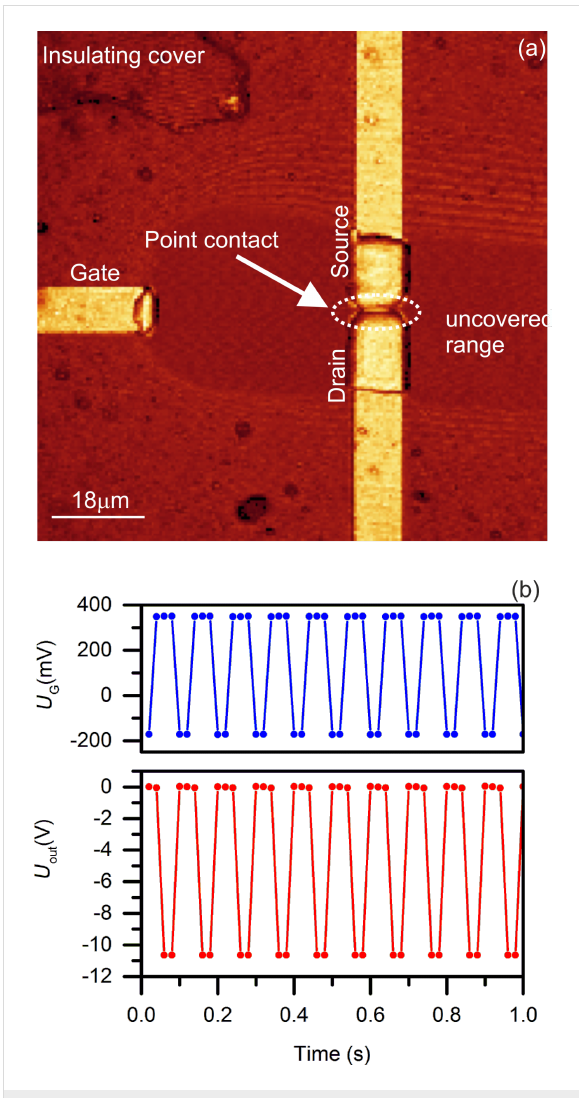
Figure 7: Influence of the copper electrolyte additives on the morphol- ogy of deposited copper film. (a) Confocal optical microscopy image of the copper atomic-scale transistor taken in situ. (b) The switching per- formance of the transistor implemented with a rectangular wave signal from a function generator applied to the gate at 10 Hz is plotted in the upper graph (blue). The output signal U out is in the lower graph (red). The sampling rate of the recording software is 50 samples/s. The solid circles are the measured data and the lines are guides to the